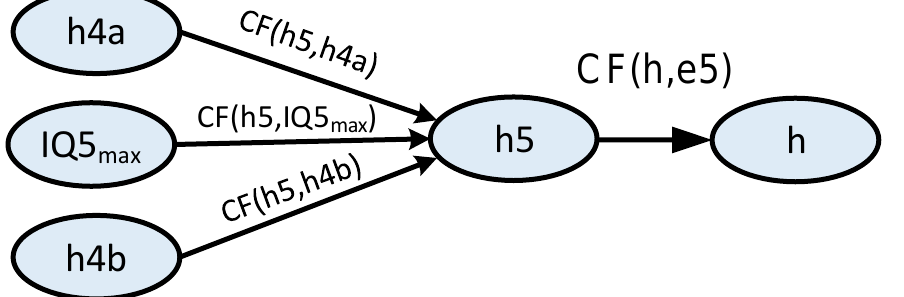
Figure 10. IQ model of the fifth information status for the example with double traffic lights (the authors’ own